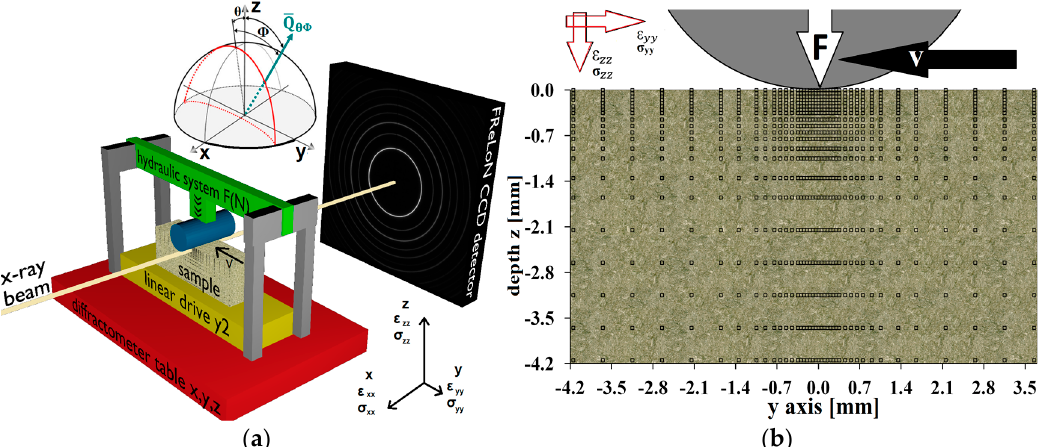
Figure 1. ( a )Schematic of deep rolling setup on ID11 in transmission measurement; ( b ) distribution of measurement positions in the contact area.